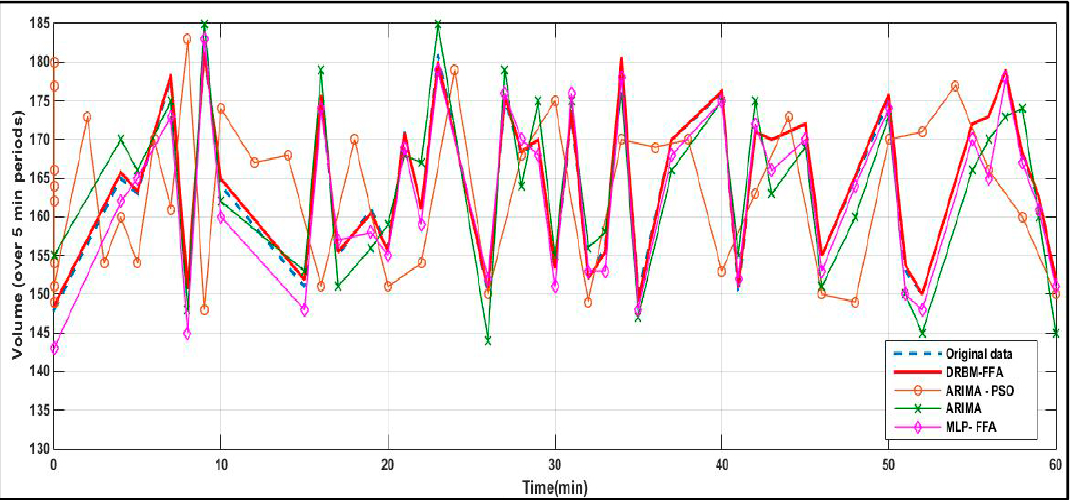
Figure 6. Prediction results by DRBM ‐ FFA, ARIMA ‐ PSO, ARIMA and MLP ‐ FFA methods.